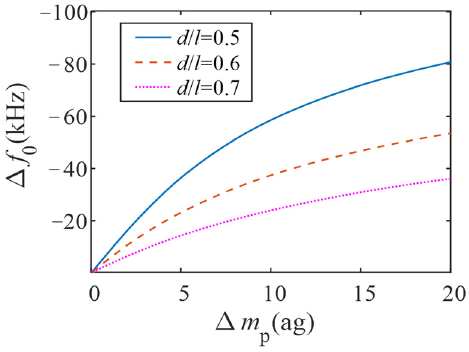
Figure 4. Effect of mass and position of adsorbed particles on resonant frequency.